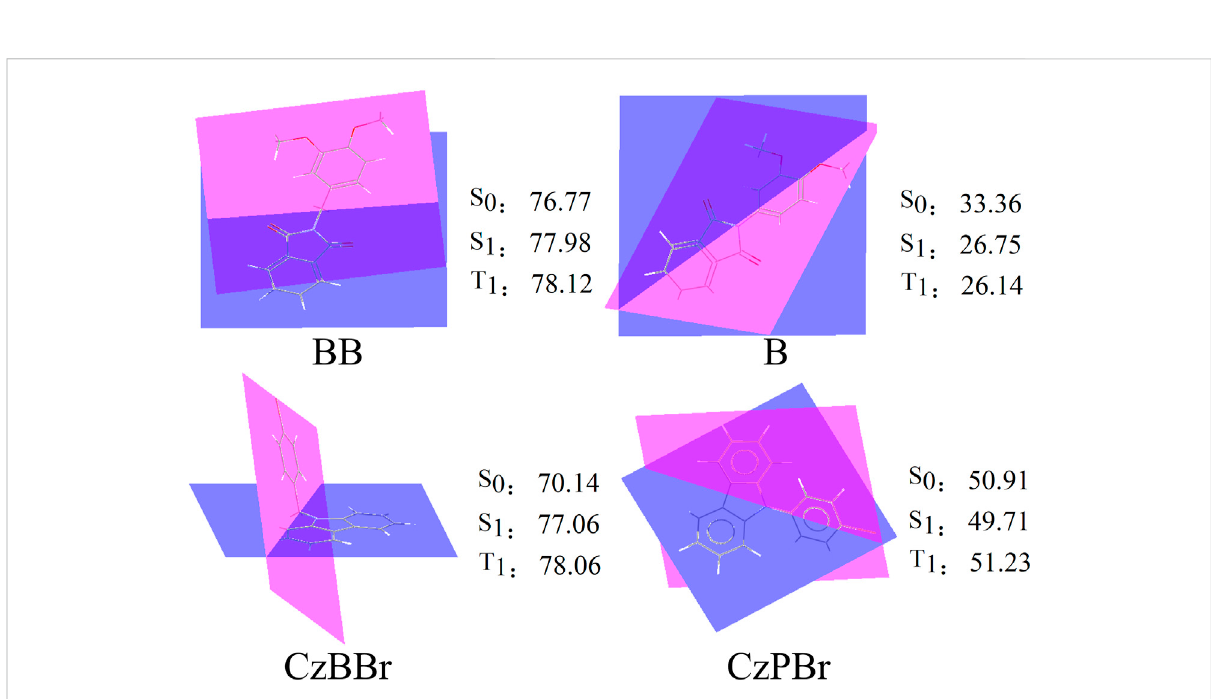
FIGURE 1 The dihedral Angle of studied